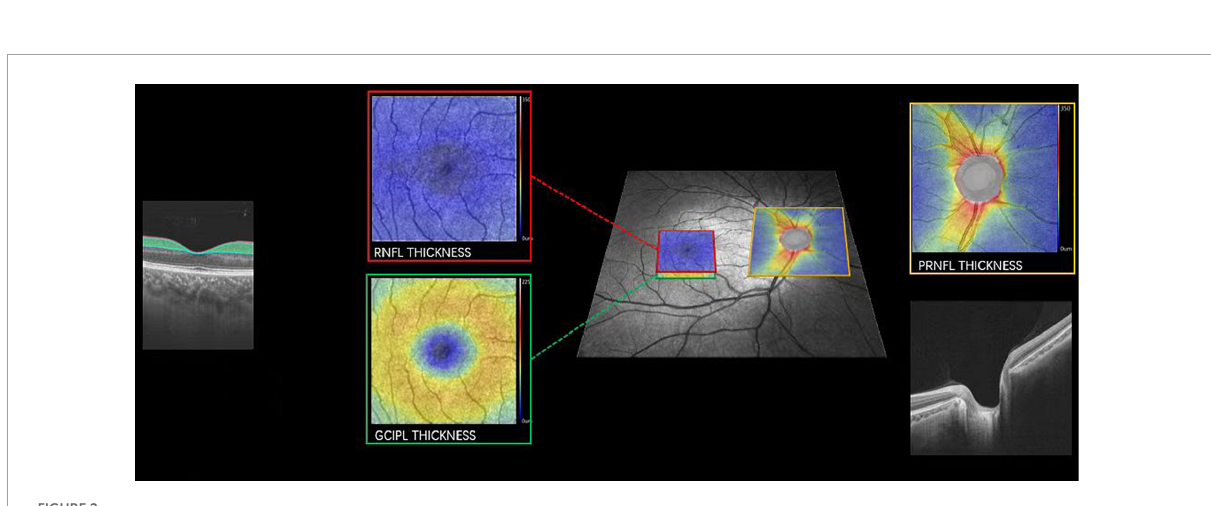
FIGURE2 Imaging of pRNFL, RNFL, and GCIPL thickness. Representative image focusing on the macula (red and green box) and optic nerve (yellow box) with the corresponding cross-sectional view of the retina. pRNFL, peripapillary retinal nerve fiber layer; RNFL, retinal nerve fiber layer; GCIPL, the ganglion cell and inner plexiform layer. A color map of the OCT structural thickness was shown to indicate the thickness. Warm colors indicate a thick structure, while cold colors indicate a thin